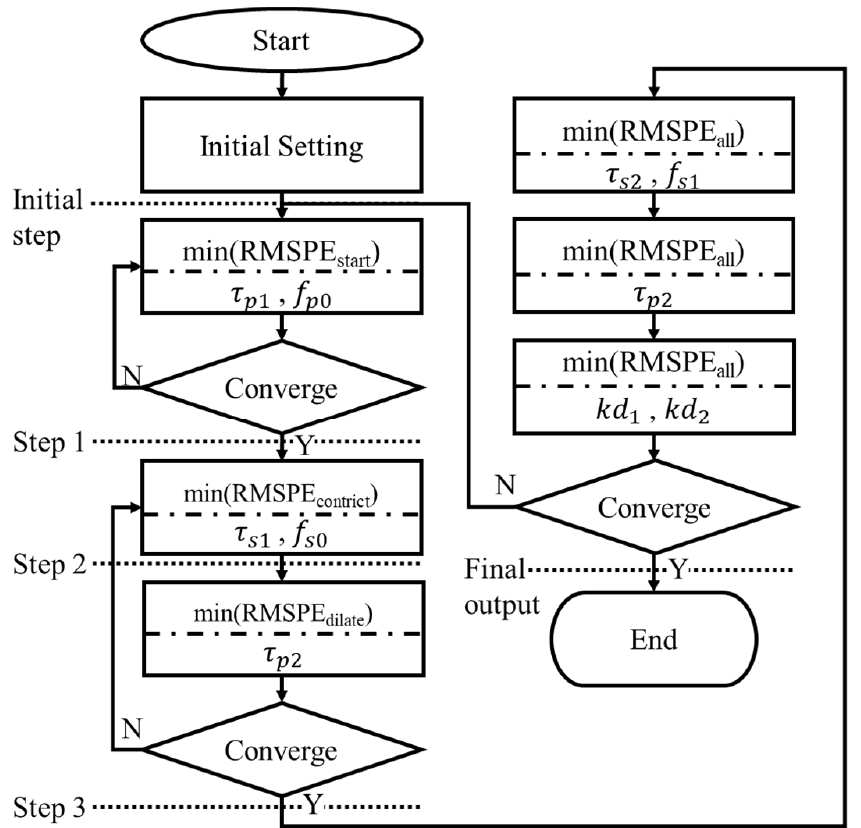
Figure 4. Flow chart of parameter estimation order in the model simulation. After a pupil starts to be stimulated by a light source for hundreds of milliseconds, it starts to constrict. It was assumed that this process is dominated by only PSNS and significantly related to τ p 1 and f p 0 ; thus, these two parameters were searched firstly, and the RMSPE start presenting the RMSPE on the time interval from the start of stimulus t s to t s + 0.4 s was calculated. SNS starts to originate the force F n with PSNS after PSNS starts to activate by hundreds of milliseconds; τ s 1 and f s 0 were assumed to dominate this process and were searched secondly; the RMSPE constrict presenting the RMSPE on the time interval from t s to the time t DCM when a pupil constricts to its minimum size was calculated. After the pupil constricts to its minimum diameter, the pupil starts to dilate; τ p 2 , which was assumed to decide the start of dilating, was searched thirdly, and the RMSPE dialate presenting the RMSPE on the time interval from t s to t s + 1.25 * (t DCM − t s ) was calculated. τ f 2 and f s 1 were assumed to dominate the process during the pupil constriction and were searched fourthly; the RMSPE all presenting the RMSPE on the time interval from t s to t s + 3 * (t DCM − t s ) was calculated. After that, τ p 2 was searched again and k d 1 and k d 2 searched afterward. Figure 5 shows the model output at the initial step, step 1, step 2, step 3, and final step. The model outputs gradually close to the beginning partition of the measured PLR response at step 1, the constricting partition of that at step 2, the dilating partition of that at step 3, and overall at the final